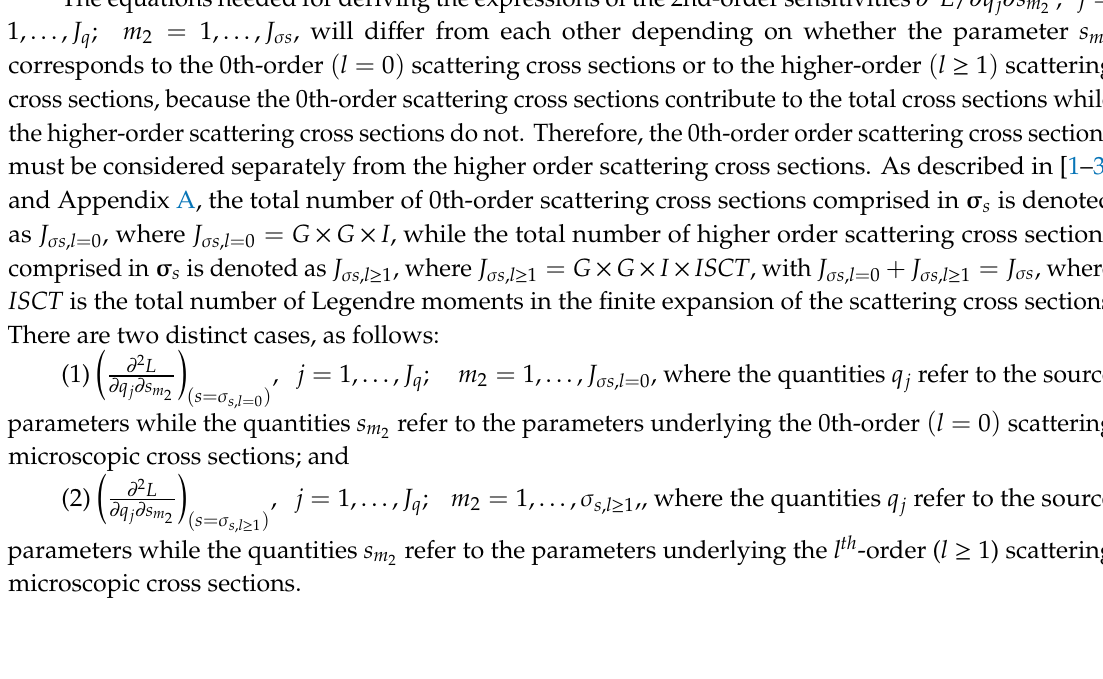
(cid:16) N 2,1 , σ g S ( 2 )